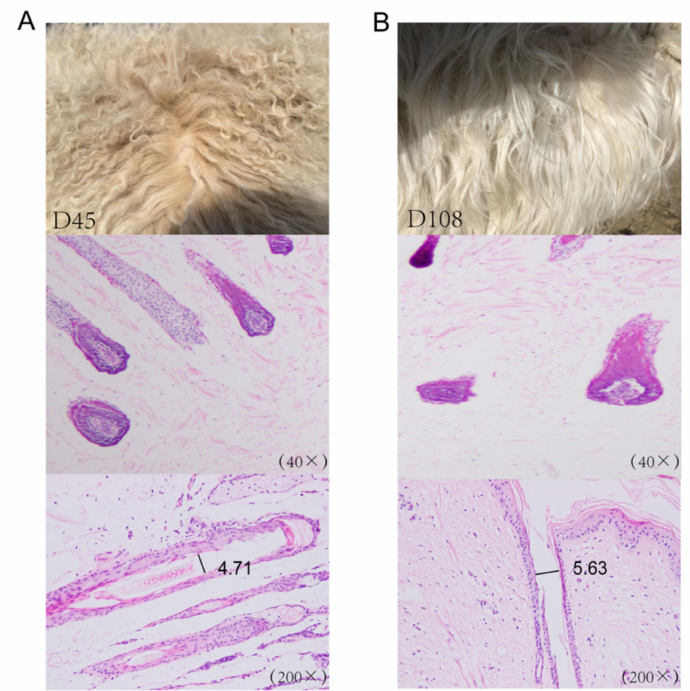
Figure 1. The dynamics of hair curling. ( A ) The pelt of a Zhongwei goat at 45 days old and a section of a single hair follicle. ( B ) The pelt of a Zhongwei goat at 108 days old and a section of single hair